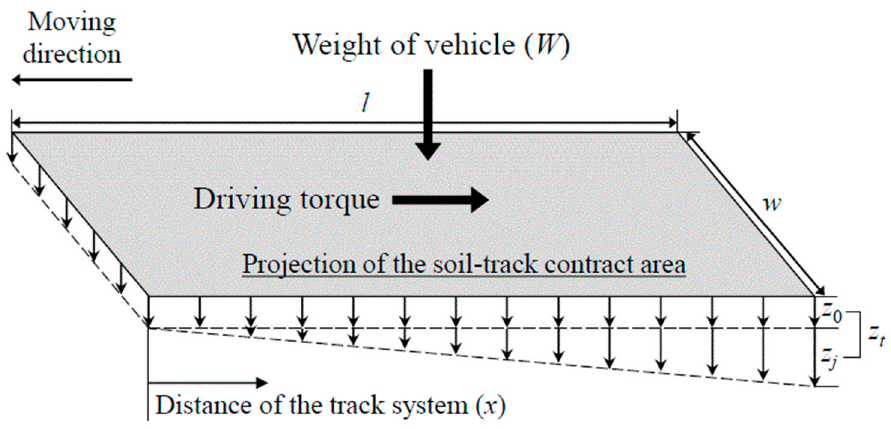
Figure 12. Ground sinkage developed on the soil–track interface.